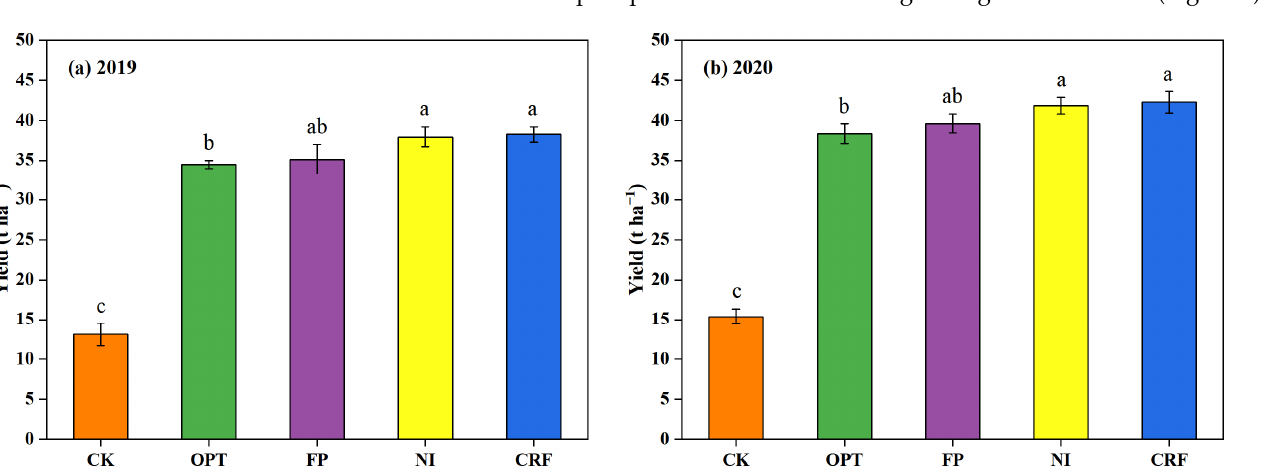
Figure 2. Fruit yield of pepper under different N management strategies in 2019 ( a ) and 2020 ( b ). Different lowercase letters indicate statistical significance at the p = 0.05 level. The vertical bars represent the standard error ( n = 4).